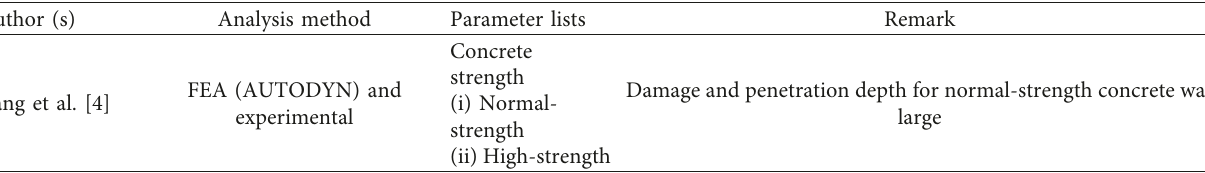
Table 10: Summary of different parameters and respective effects on mass concrete target and concrete blocks under combined blast and fragment impact